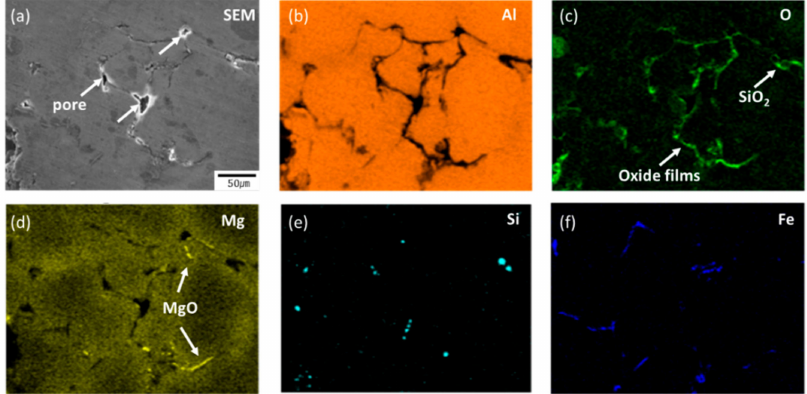
Figure 6. SEM microscope images ( a , b ) and ( c ) EDS results of pore in the reduced-pressure sample of Al-4Mg alloy cast at 800 ◦ C.